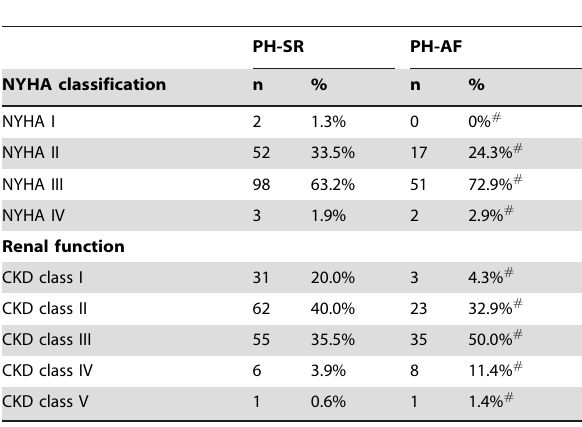
Table 2. Effect of AF on NYHA class and renal function in